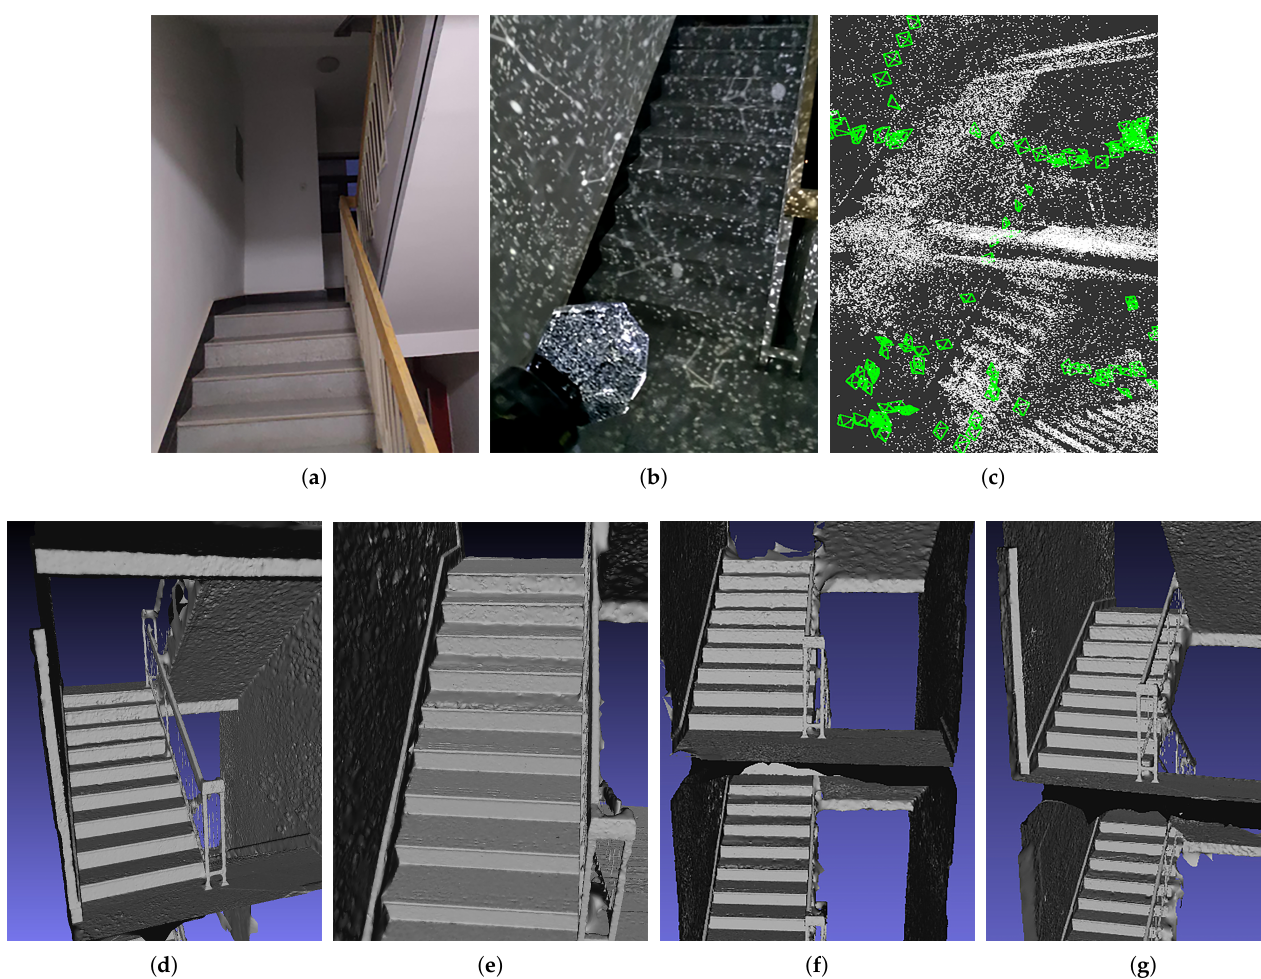
Figure 7. Reconstruction of a staircase. ( a ) The staircase under regular light; ( b ) One light source and stair with the spark pattern; ( c ) Sparse reconstruction and the camera poses; ( d – g ) Different views of a part of reconstructed staircase.